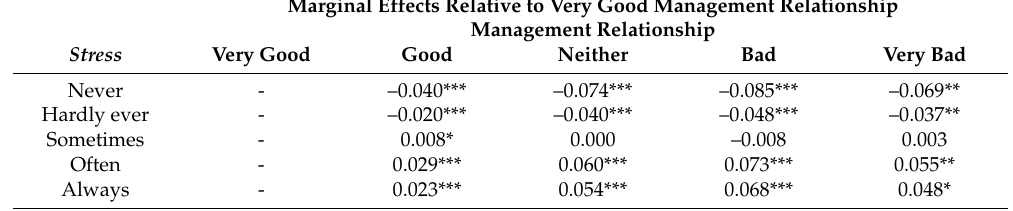
Table A6. Estimated marginal effect of relationship between management/staff on work-related Stress—males.